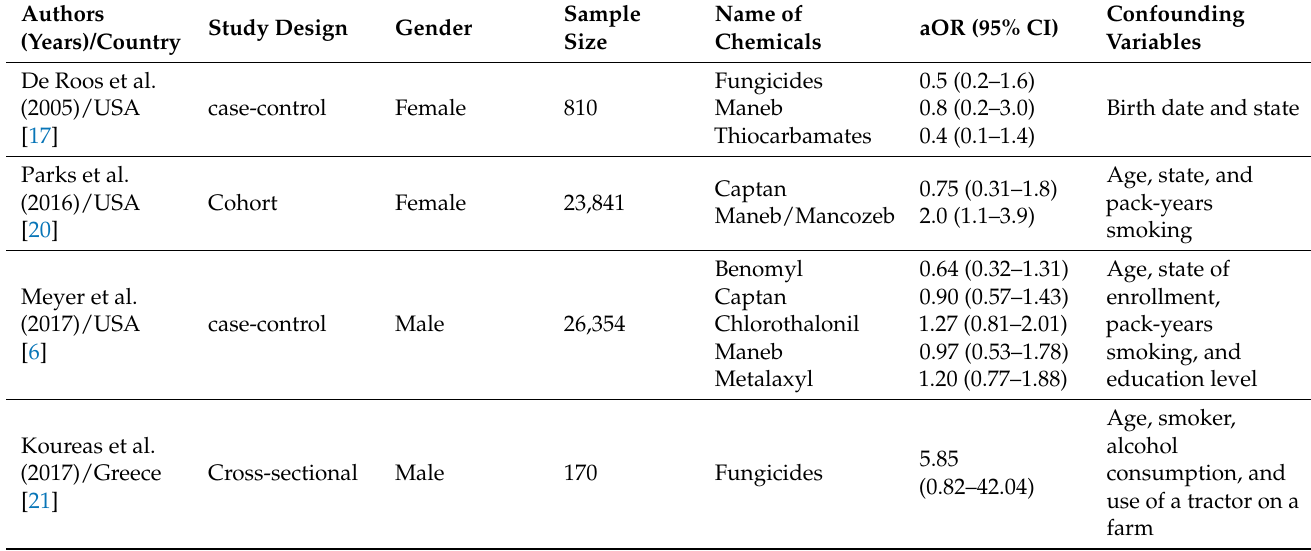
Table 3. The association between exposure to fungicides and RA development.